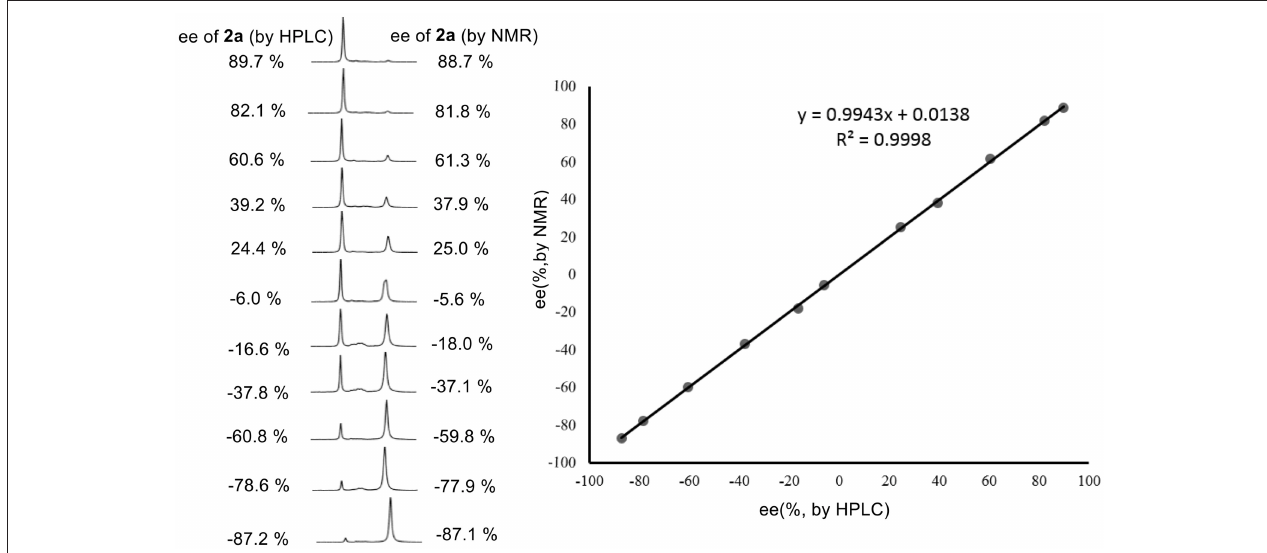
FIGURE 3 | 1 H NMR signals of non-racemic 2a samples in the presence of 1 equiv. of 1a in CDCl 3 ( left ); linear relationship between NMR measured ee values versus the HPLC determined ee values ( right